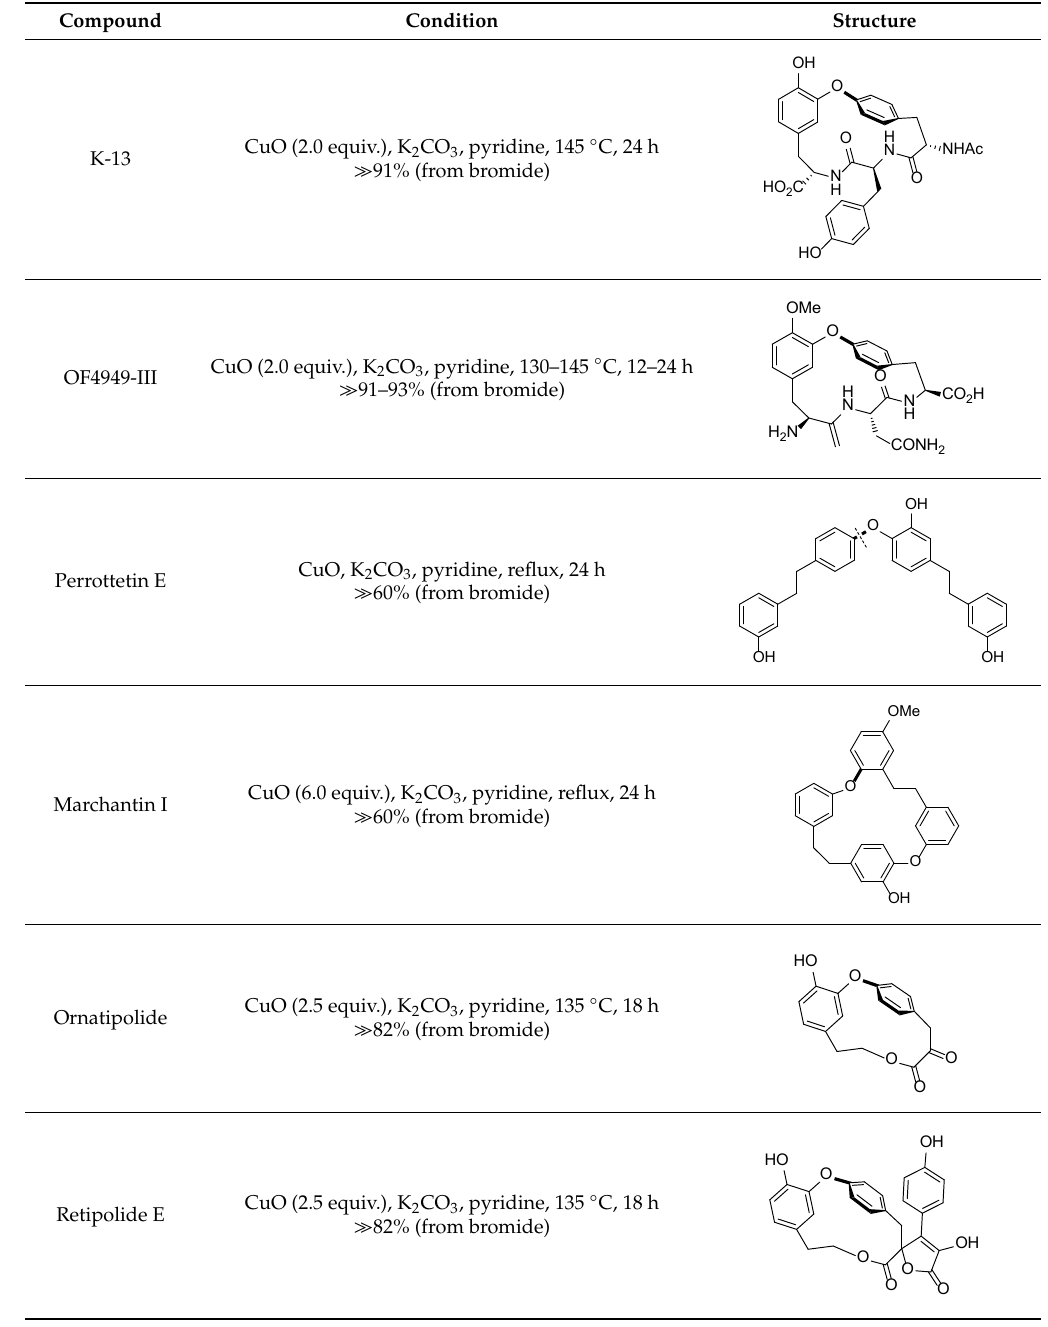
Table 11. The macrocyclic ether compound heptanoids that occur naturally prepared through an intramolecular Ullmann coupling reaction based on the condition that proposed by Tomita, Fujitani, and Aoyagi.